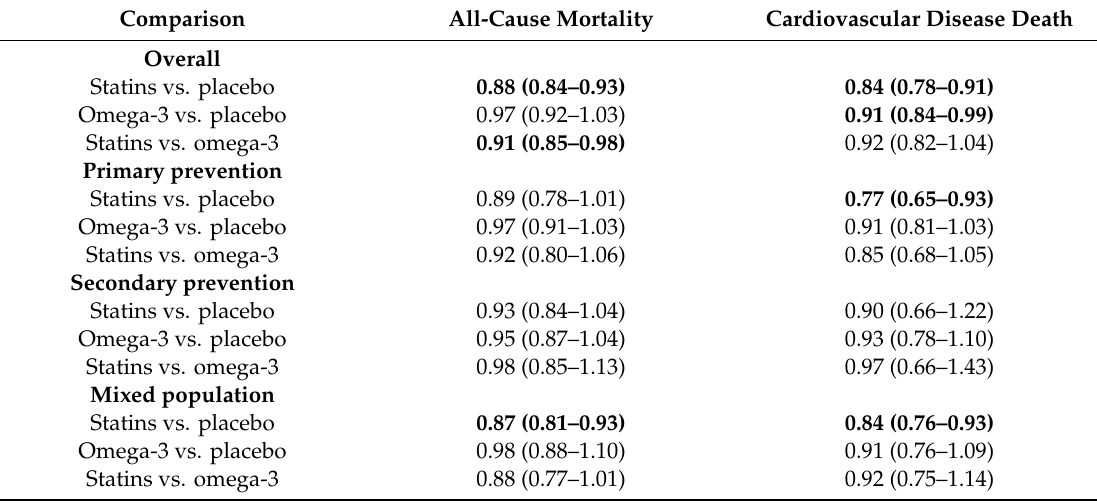
Table 2. Relative risks and 95% confidence intervals from network meta-analysis of omega-3 supplementation, statins, and placebo e ff ects on all-cause mortality and cardiovascular disease death. Comparison All-Cause